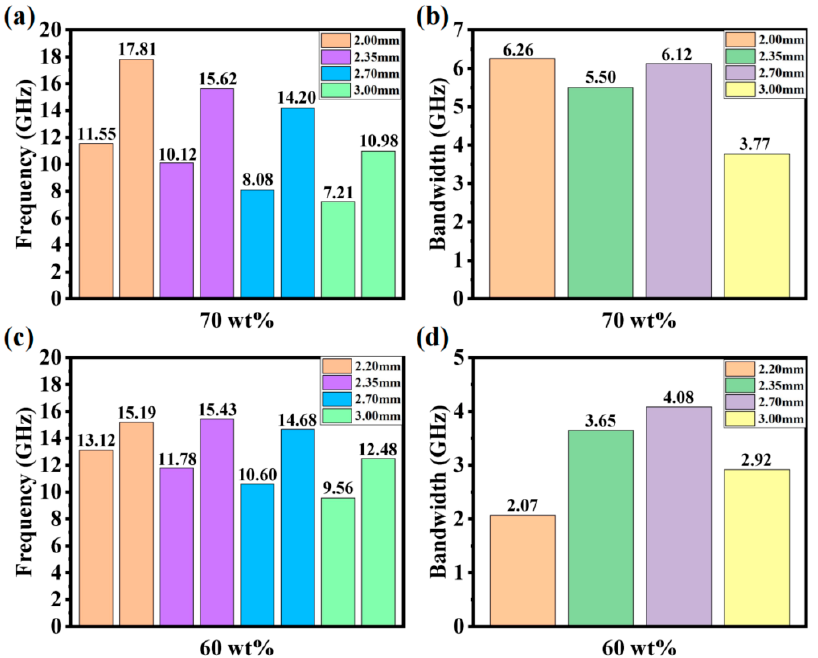
Figure 9. ( a ) Frequency absorption range and ( b ) effective absorption bandwidth of FeNi 3 sample with 70 wt% filling ratio; ( c ) frequency absorption range and ( d ) effective absorption bandwidth of FeNi 3 sample with 60 wt% filling ratio.